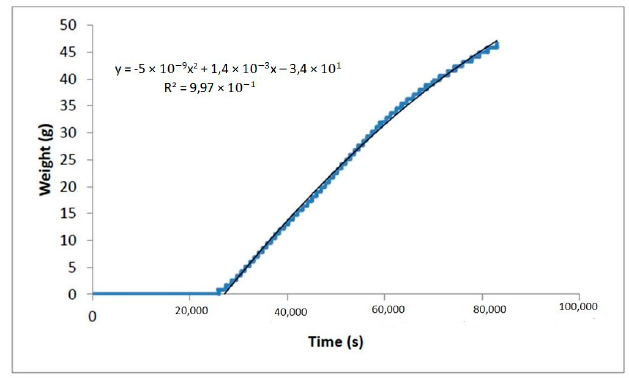
Figure 5. Water flow through OSB with nanofibrous membrane.